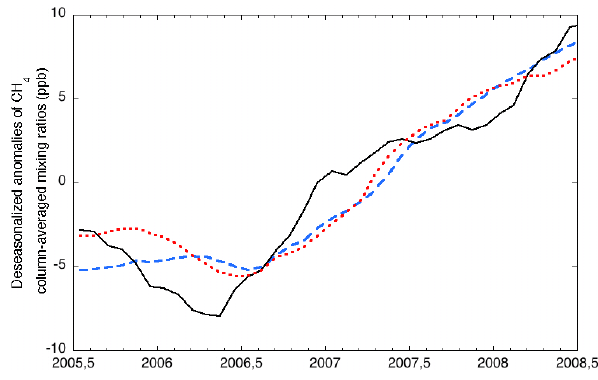
Fig. 2. Mean CH 4 column-averaged mixing ratio anomalies for South America for the 2005–2008 period (in ppb), as retrieved by SCIAMACHY on ENVISAT (solid black), by INV1 (dashed blue) and by INV2 (dotted red). A 12-month running mean was applied to the monthly column-averaged mixing ratios, and their mean over 2006–2008 was subtracted to compute the